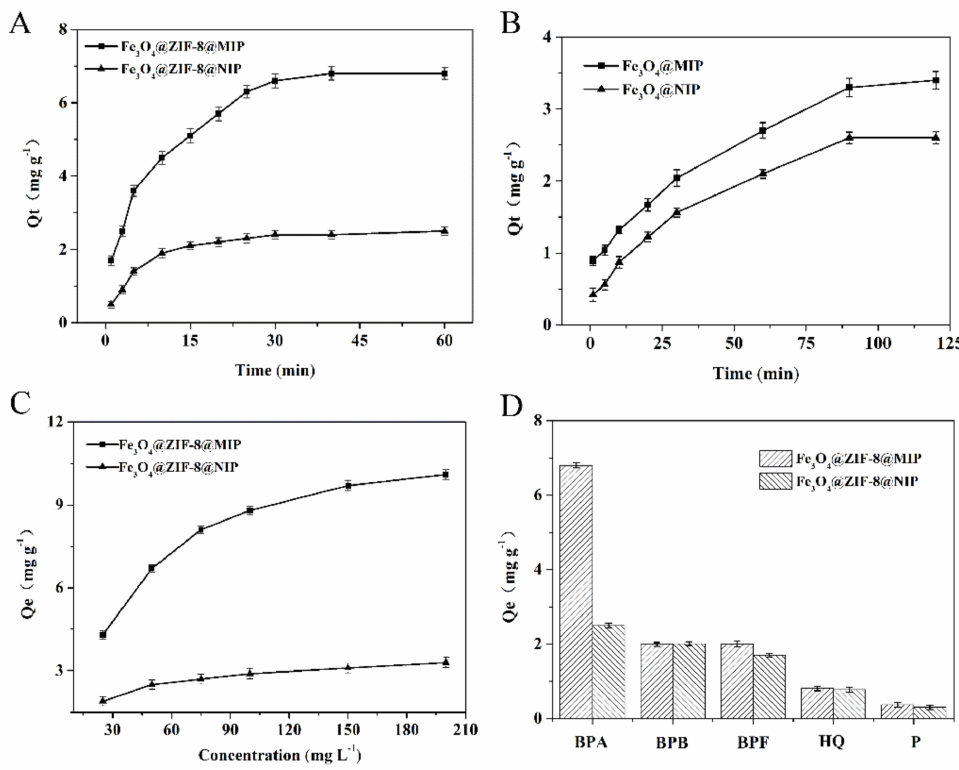
Figure 3. ( A ) Adsorption of BPA (50 mg L − 1 ) by Fe 3 O 4 @ZIF-8@MIP and Fe 3 O 4 @ ZIF-8@NIP at different incubation times (1, 3, 5, 10, 20, 25, 30, 40, and 60 min); ( B ) adsorption of BPA (50 mg L − 1